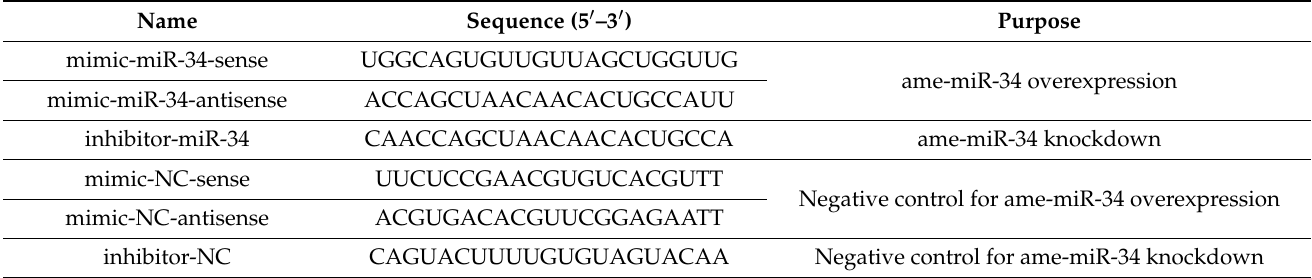
Table 2. Detailed information about mimics and inhibitors used in this